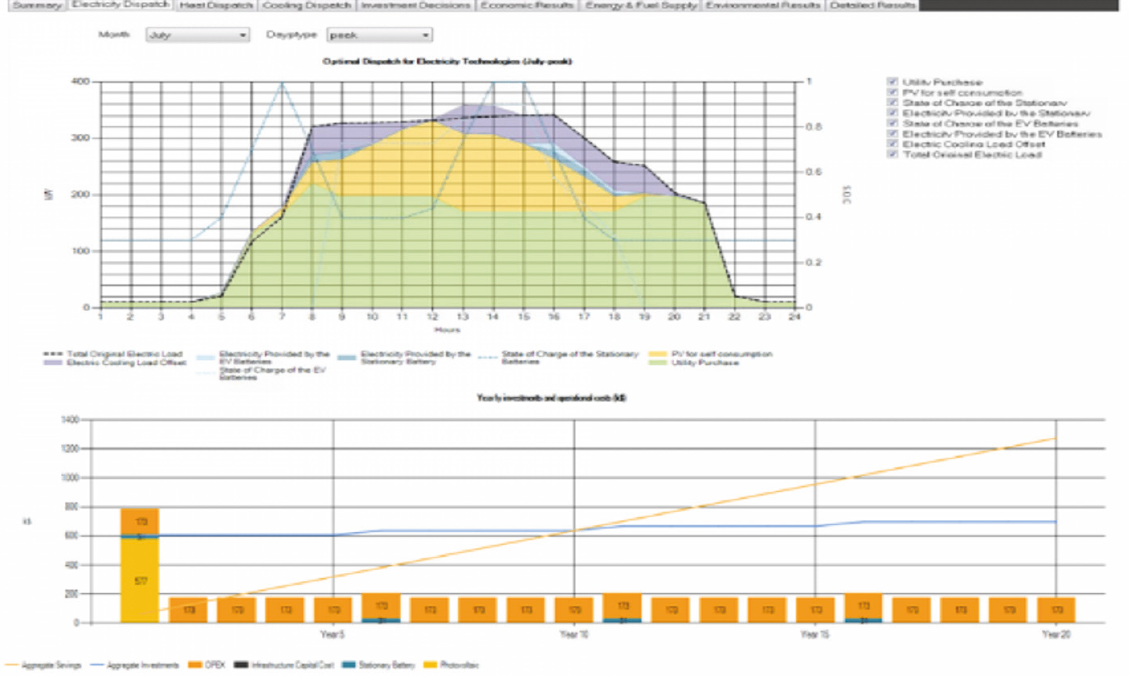
Figure 4: DER-CAM output sample (Source: